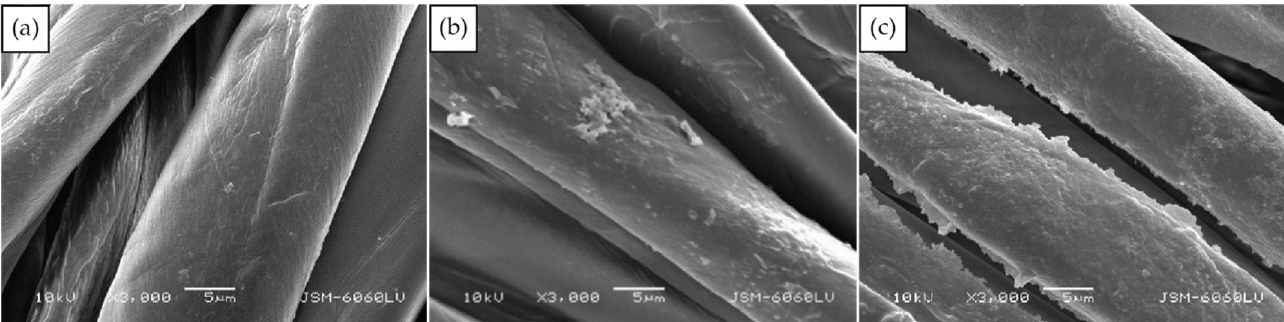
Figure 3. SEM images of untreated cotton sample ( a ) and cotton samples functionalised with proto ‐ col Ash + Extr + 0.1 ZnAc ( b ) and Ash + 0.1 ZnAc + Extr ( c ).